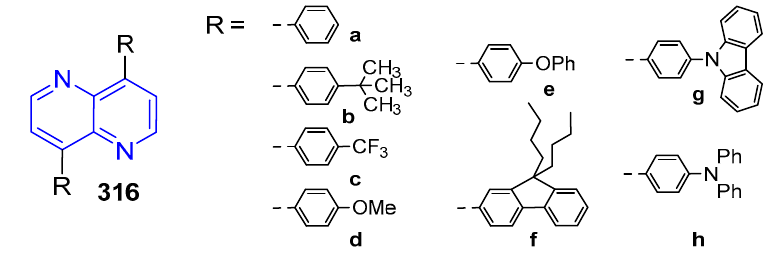
Figure 39. Organic light-emitting Figure 39. O rganic light-emitting diodes.